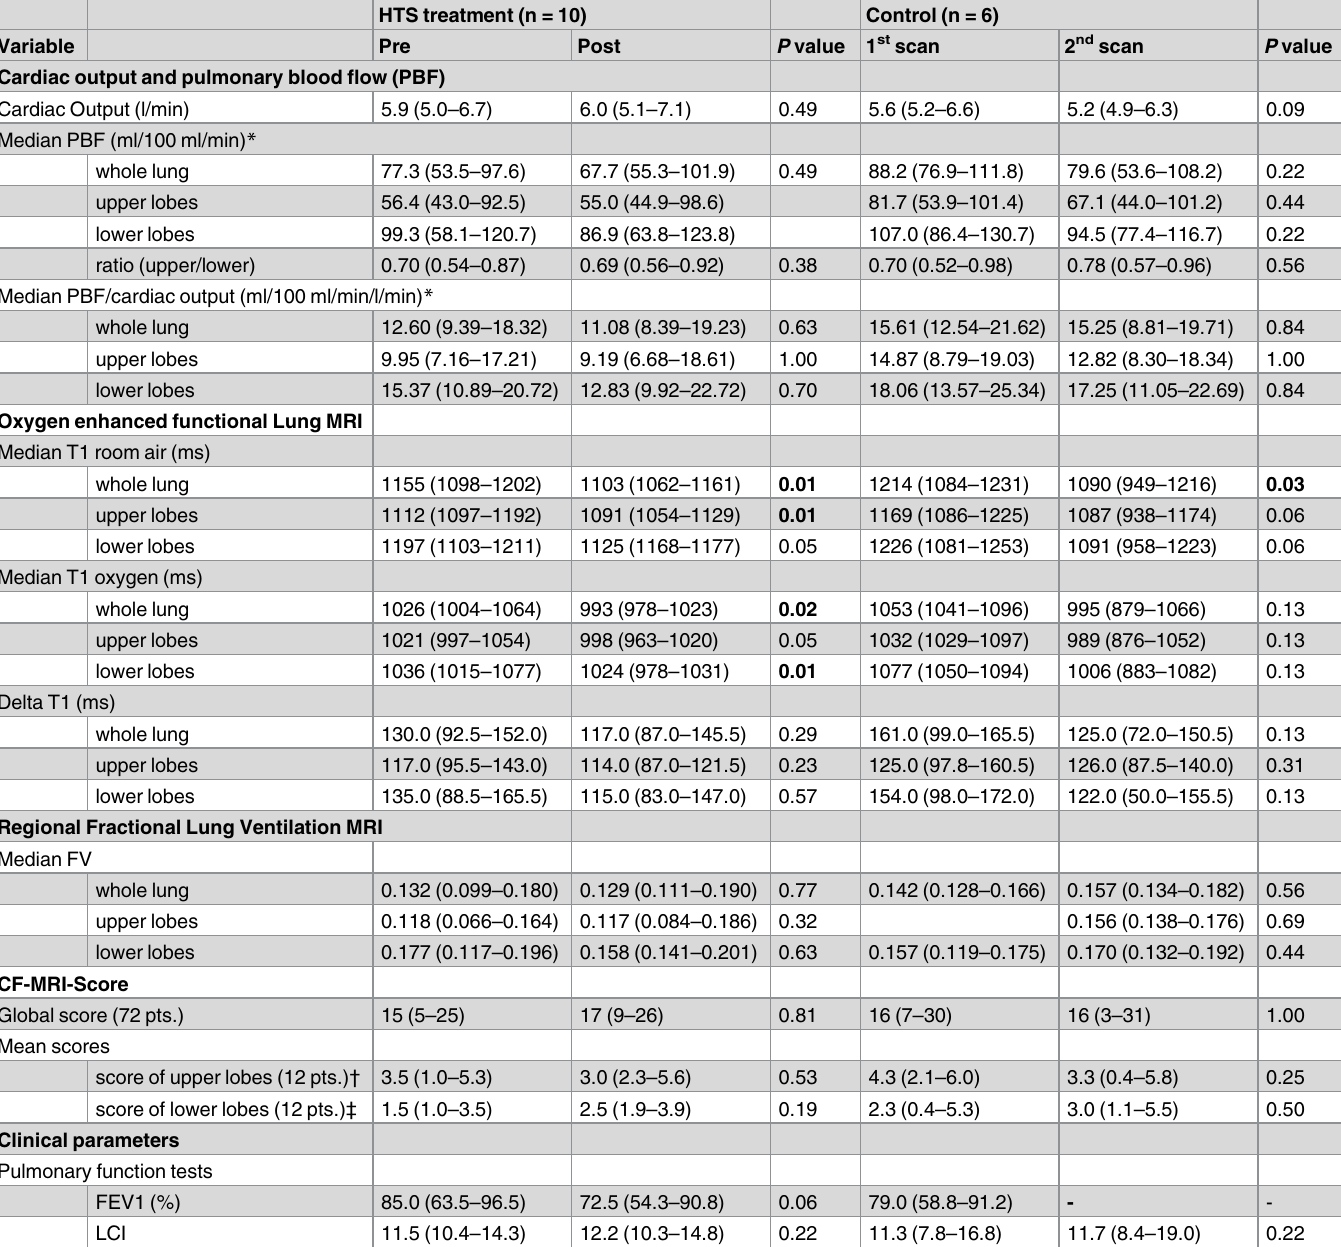
Table 4. Functional lung MRI of the CF patient cohort pre and post hypertonic saline treatment vs CF